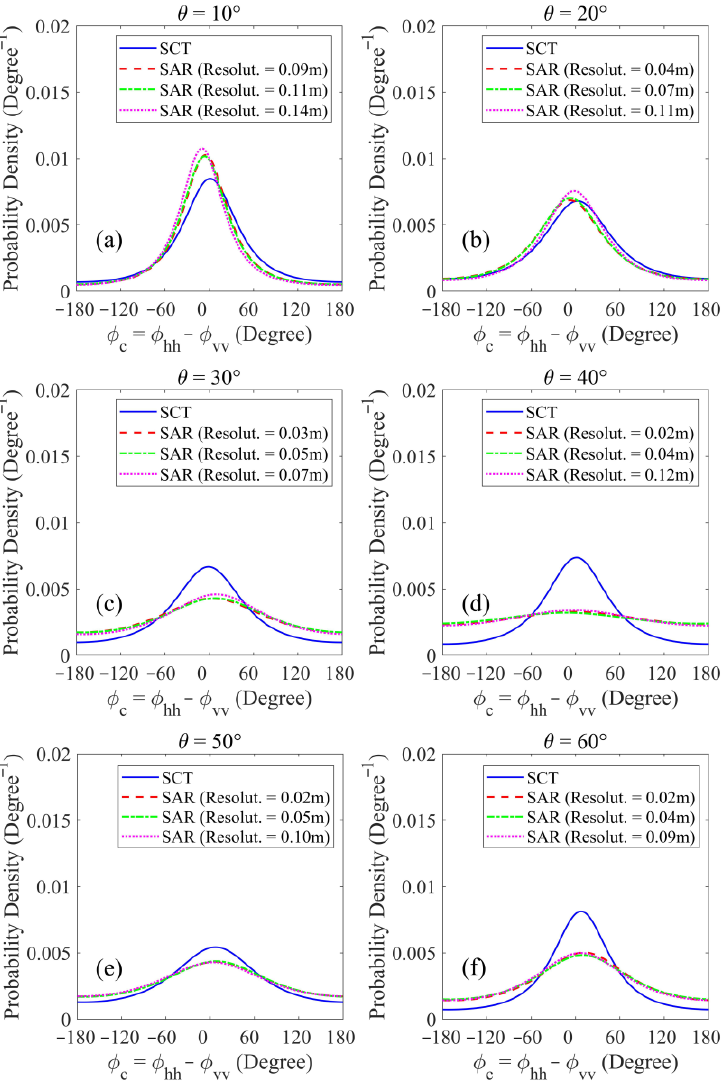
Figure 22. Comparisons of theoretical PDFs of the co-pol phase difference between scatterometric and SAR data with three different resolutions at incidence angles of ( a ) 10°, ( b ) 20°, ( c ) 30°, ( d ) 40°, ( e ) 50°, and ( f ) 60°.